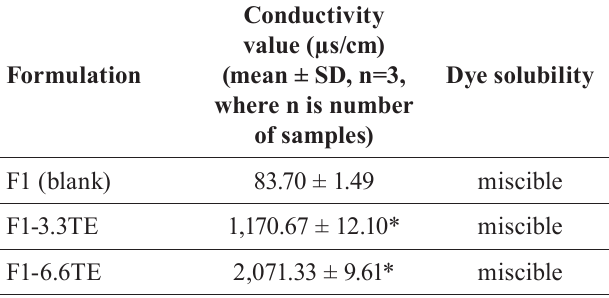
TABLE IV - Conductivity and dye solubility tests of blank nanoemulsion and tamarind extract loaded nanoemulsions